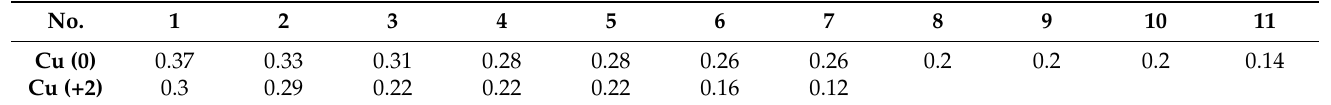
Figure 5. Atomic structures of the transition state in the migration path (red, blue, and brown spheres represent O, Hf, and Cu, respectively. Atoms with a displacement greater than 0.1 Å are marked with numbers). Table 4. Displacement of the atoms labeled in Figure 5 (the numbers are consistent with the marked in Figure 5) (Unit: Å).